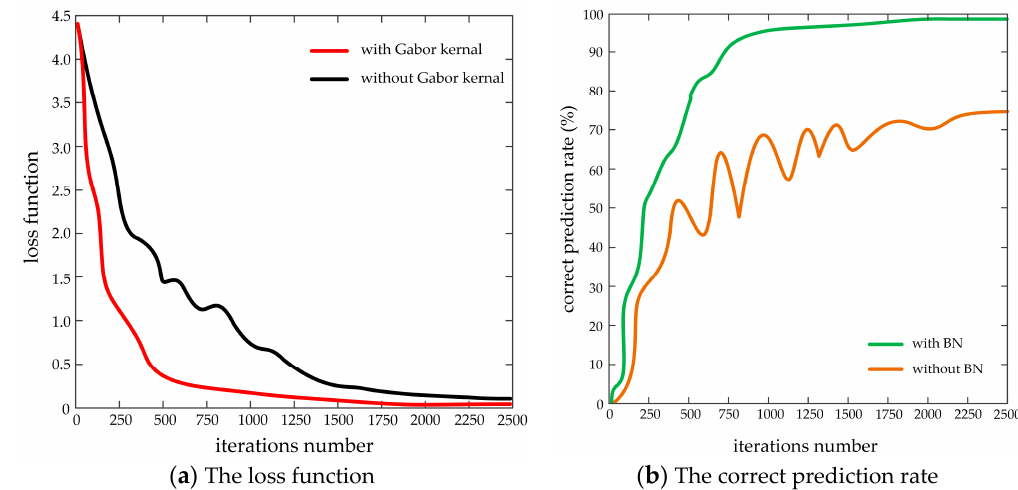
Figure 12. The dynamic change curve of relevant parameters in the network training stage.